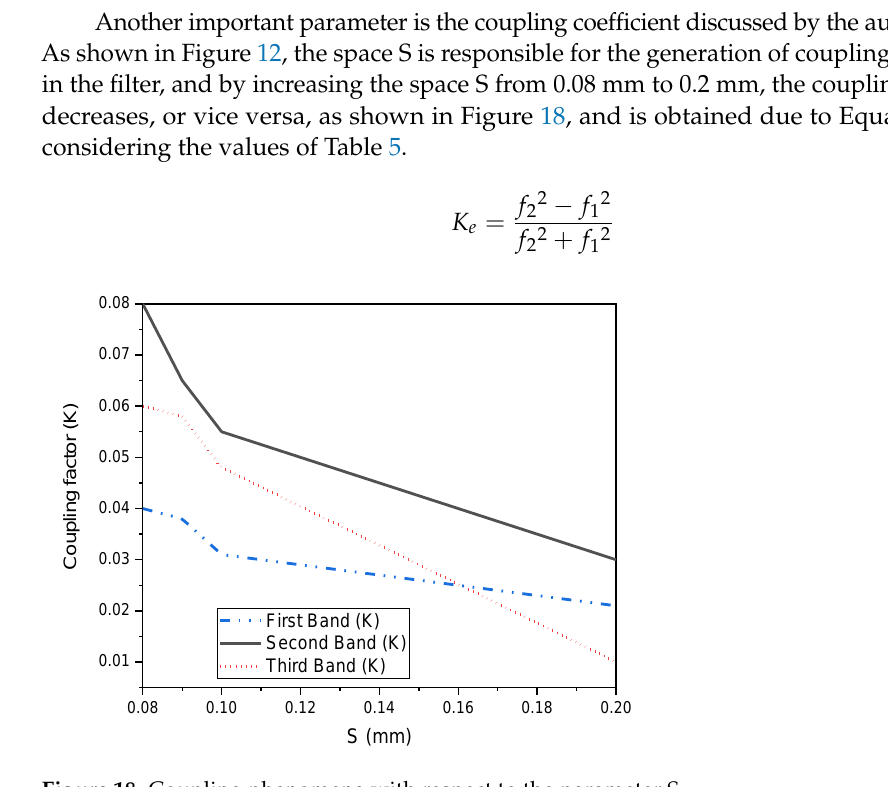
Table 5. Simulated result of “K” for different values of S.